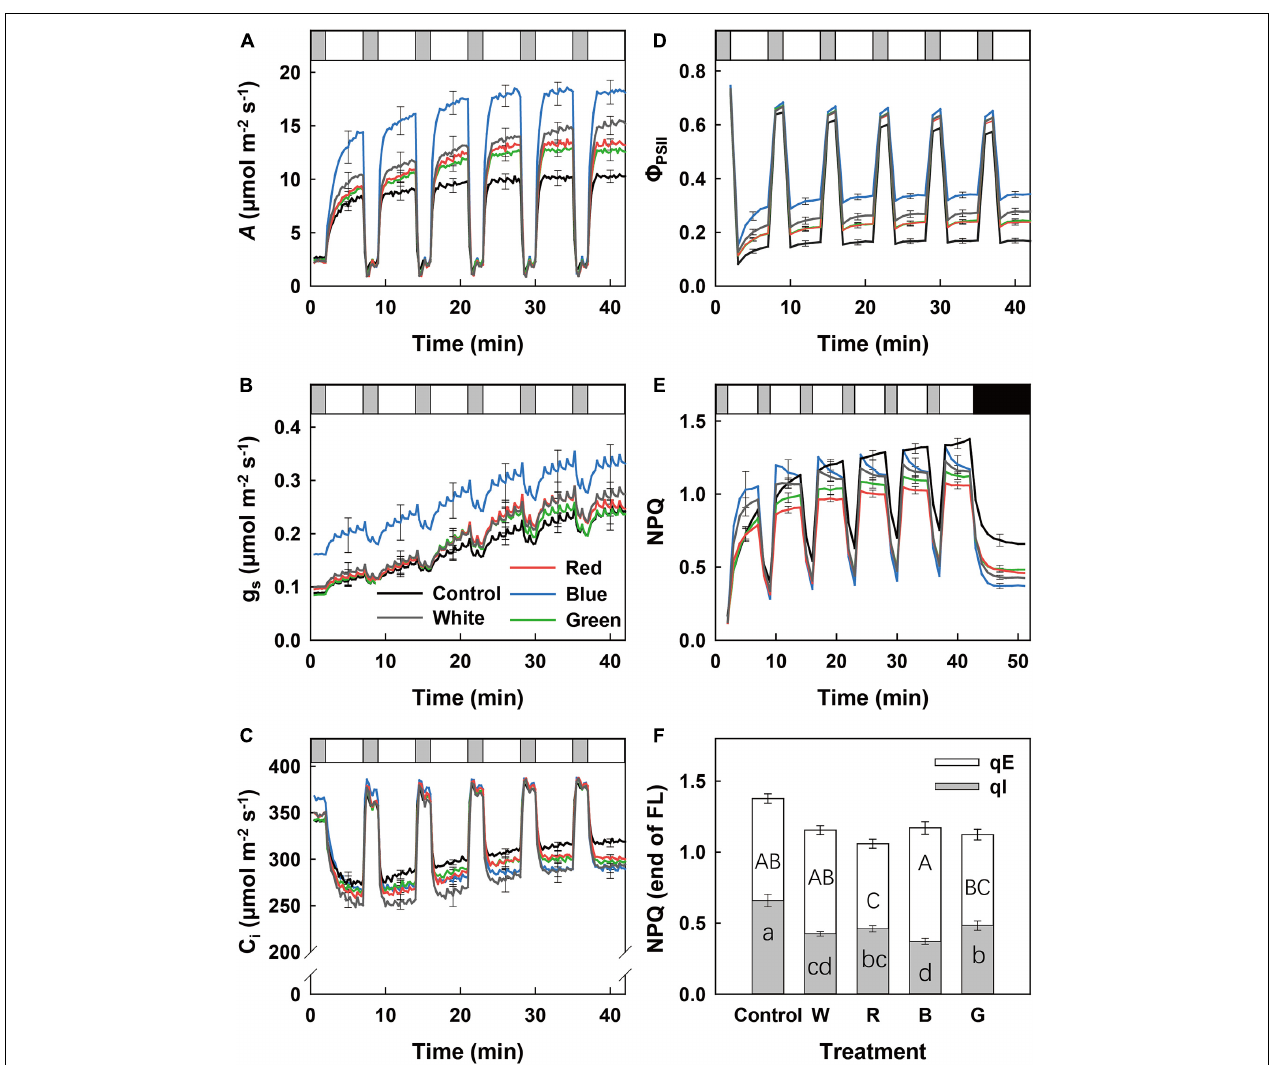
FIGURE 2 | Dynamic leaf photosynthetic traits of cucumber plants grown under different light treatments in response to fluctuating light (FL) intensity. Time courses of net photosynthesis rate ( A ; A ), stomatal conductance (g s ; B ), leaf internal CO 2 partial pressure (C i ; C ), photosystem II electron transport efficiency ( (cid:56) PSII ; D ), and non-photochemical fluorescence quenching (NPQ; E ) when a leaf adapted to low irradiance (50 µ mol m − 2 s − 1 ) was exposed to FL between 2 min of low light (LL) (50 µ mol m − 2 s − 1 ) and 5 min of high light (HL) intensity (1,000 µ mol m − 2 s − 1 ) for 42 min (five repeated cycles). NPQ dark relaxation was recorded for another 10 min after FL in panel (E) . LL, HL, and darkness are visualized as gray, white, and black bars, respectively. Energy and zeaxanthin-depended quenching (qE) and photoinhibitory quenching (qI) at the transition from HL to darkness are shown in panel (F) . Control (C, shade solar light), white (W), red (R), blue (B), and green (G). Mean value ± SEM of three experimental batches are shown ( n = 3), with three replicate plants per experimental batch. Different letters in panel (F) indicate significant treatment effects on qE (capital letter) and qI (lowercase letter), respectively.